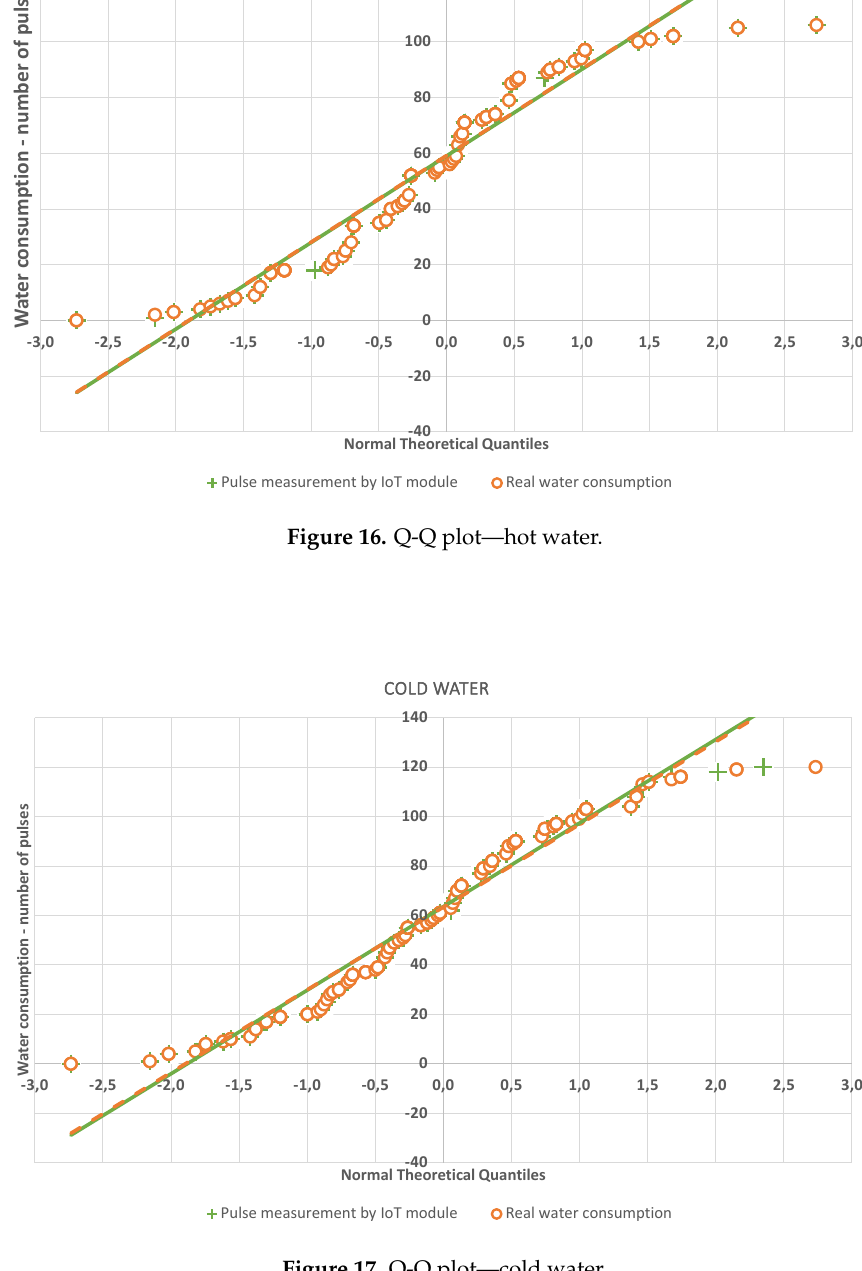
Figure 17. Q-Q plot—cold